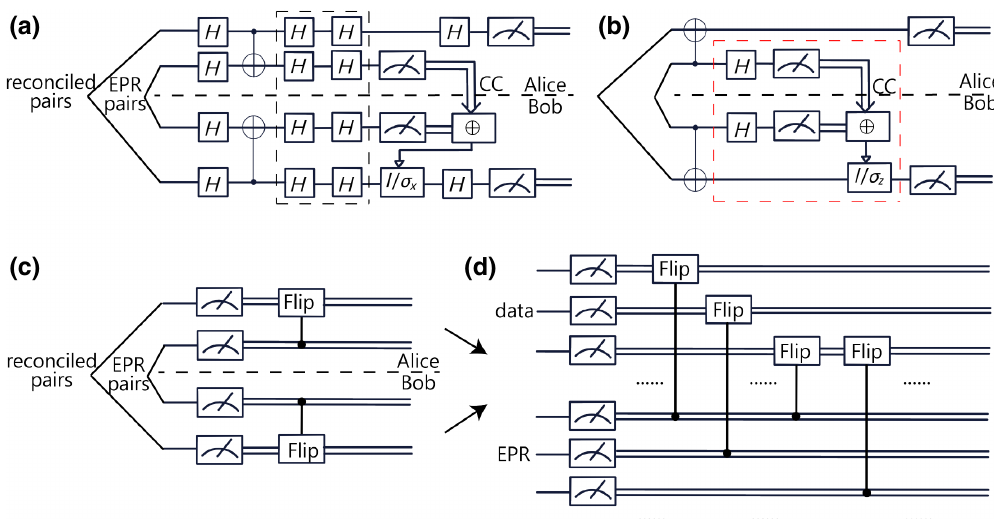
FIG. 2. Circuit (a) is derived from the quantum phase-error-correction phase in Fig. 1 by adding Hadamard gates in dashed boxes that form identity operations. We take one pair of CNOT operations for illustration. Circuit (b) is equivalent to circuit (a) by considering